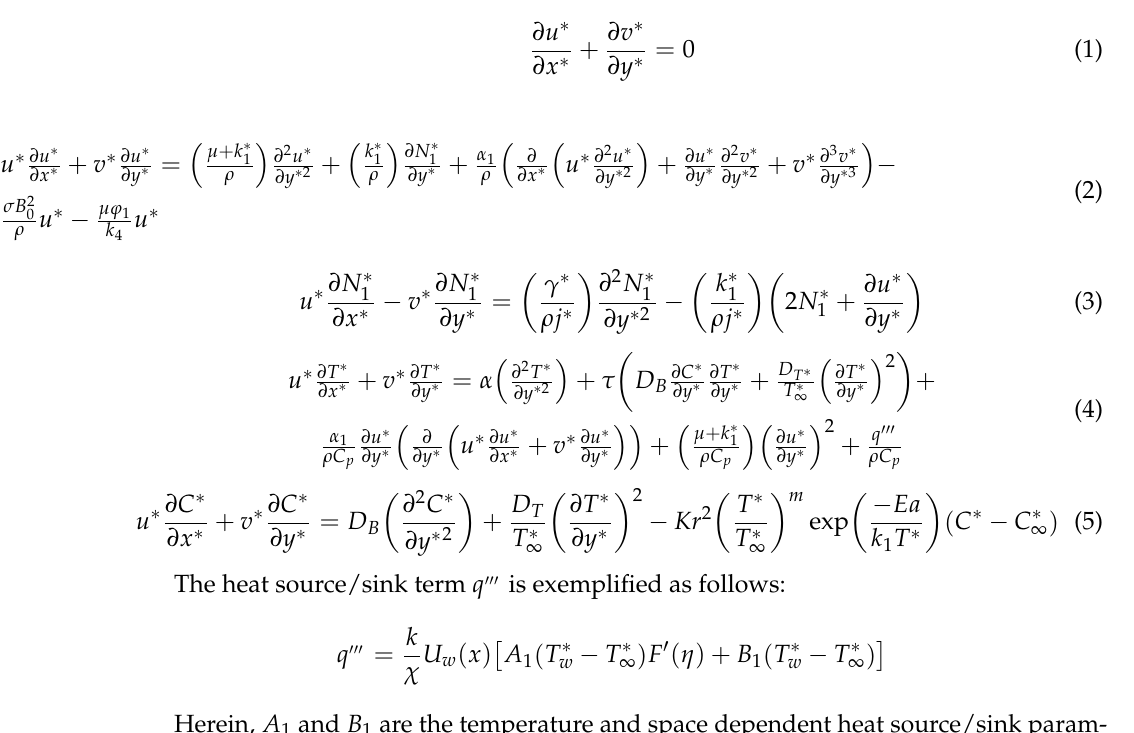
Figure 1. ( a ) Flow configuration and the coordinates [8]. ( b ) Flow chart of numerical algorithm [8]. A revised mathematical model is established under the opted assumptions by means of boundary layer approximation in the form of PDES are offered below